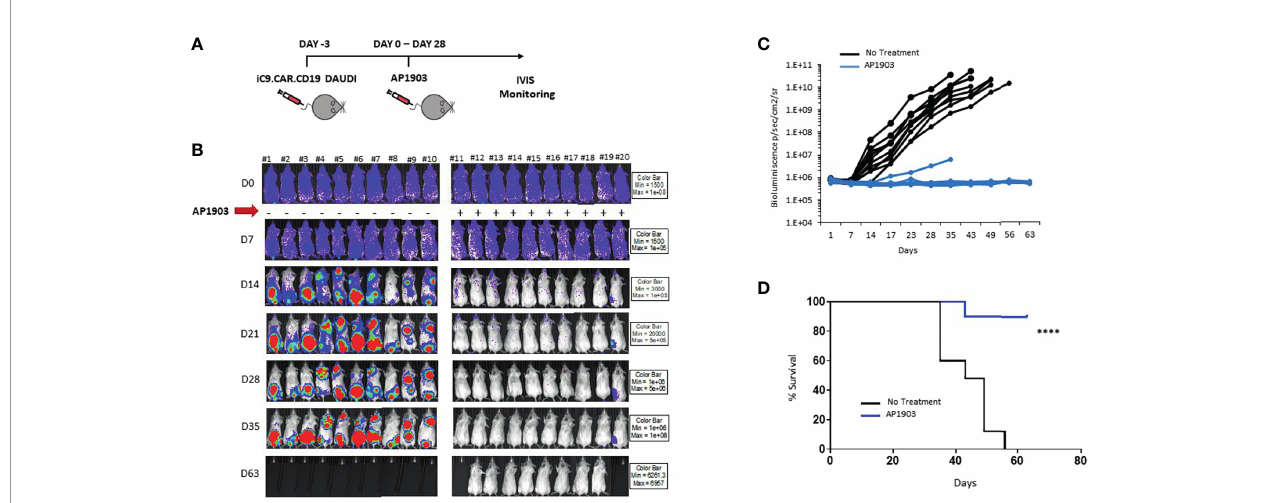
FIGURE 4 | iC9 activation is able to control in vivo expansion of CAR-positive lymphoma in a xenograft mouse model. (A) Schematic representation of the experimental design, with iC9.CAR.CD19-positive/FF-Luciferase-positive DAUDI cells infused at day − 3. At day 0, mice were evaluated for leukemia engraftment and treated with 100 µg/mouse of AP1903 from day 0 to day 28. (B) Bioluminescence images of each control untreated mouse and each AP1903-treated mouse. Mice were monitored for more than 30 days after AP1903 withdrawal. (C) Bioluminescence values over time for each treated mouse in the two cohorts, untreated (black lines) or AP1903-treated (blue line) mice. (D) Kaplan-Meier survival curve analysis of leukemia-bearing mice untreated (black line) or AP1903-treated (blue line). ****p-value ≤ 0.00001. The only mouse (#20) showing a persisting positive signal at IVIS analysis after AP1903 administration was sacri fi ced at day+43 together with a negative control (#11), to characterize the leukemia